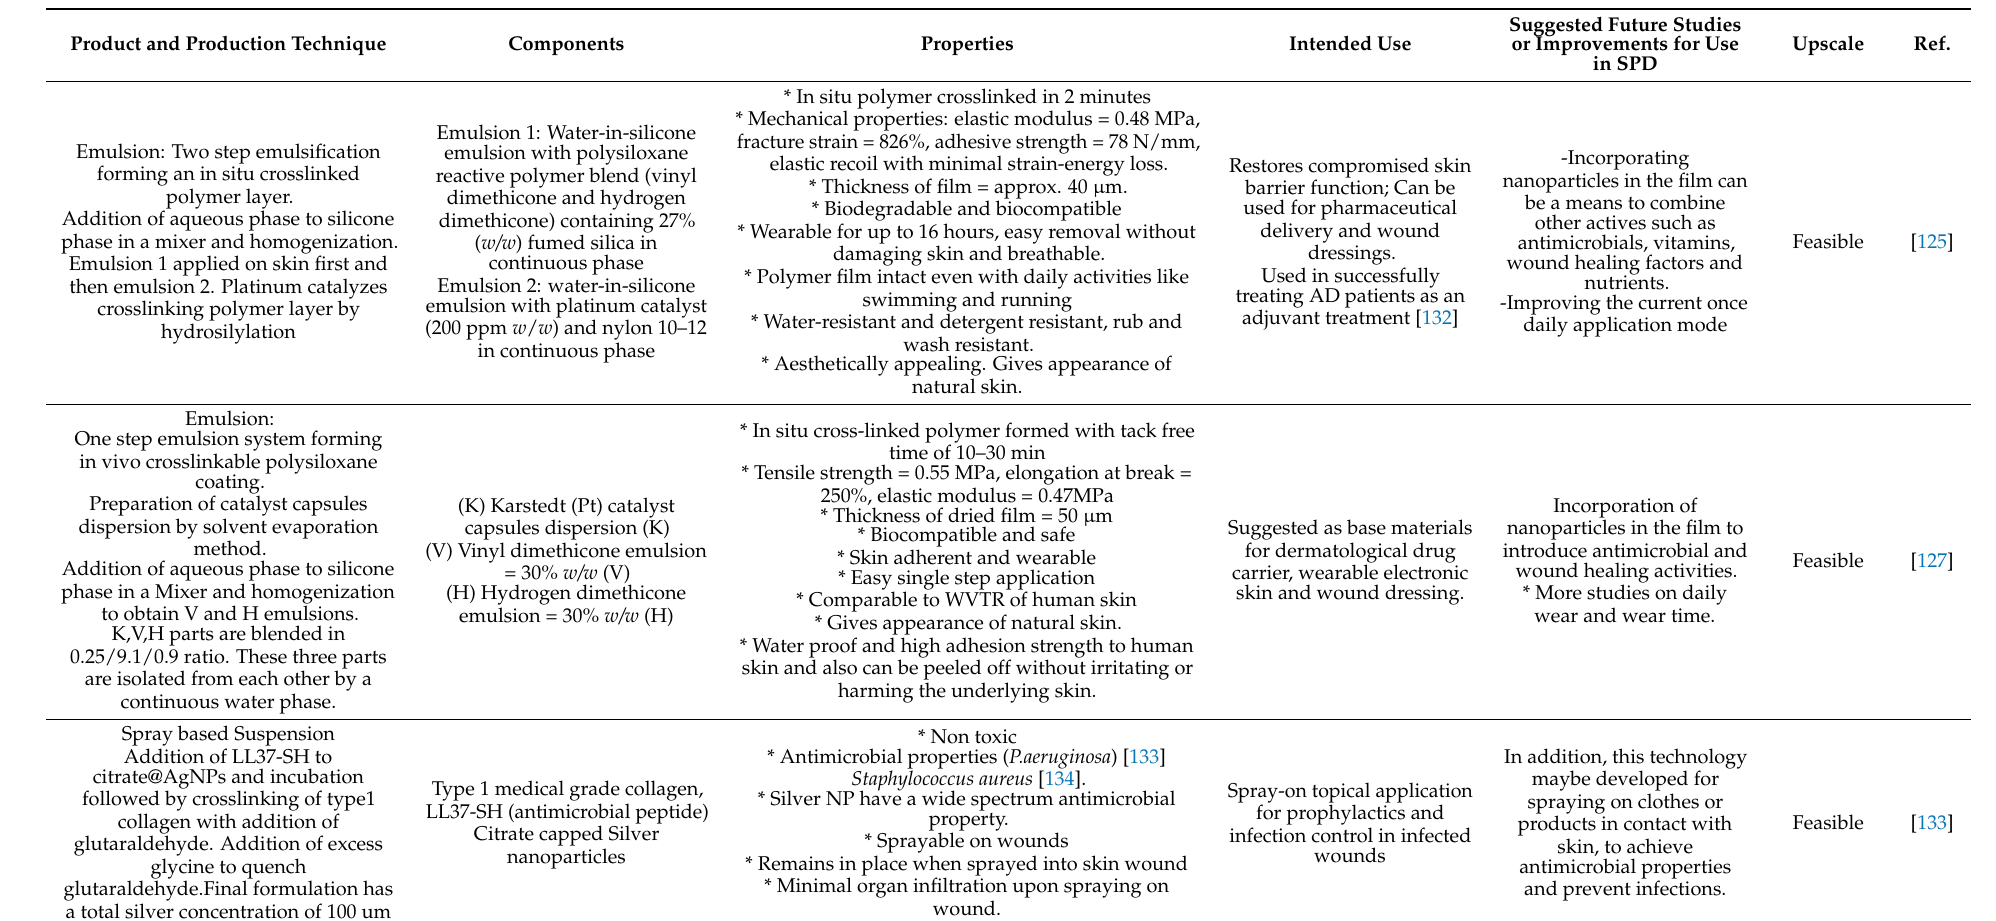
Table 4. Biomaterials or products in research which may be adapted for treating skin picking disorder